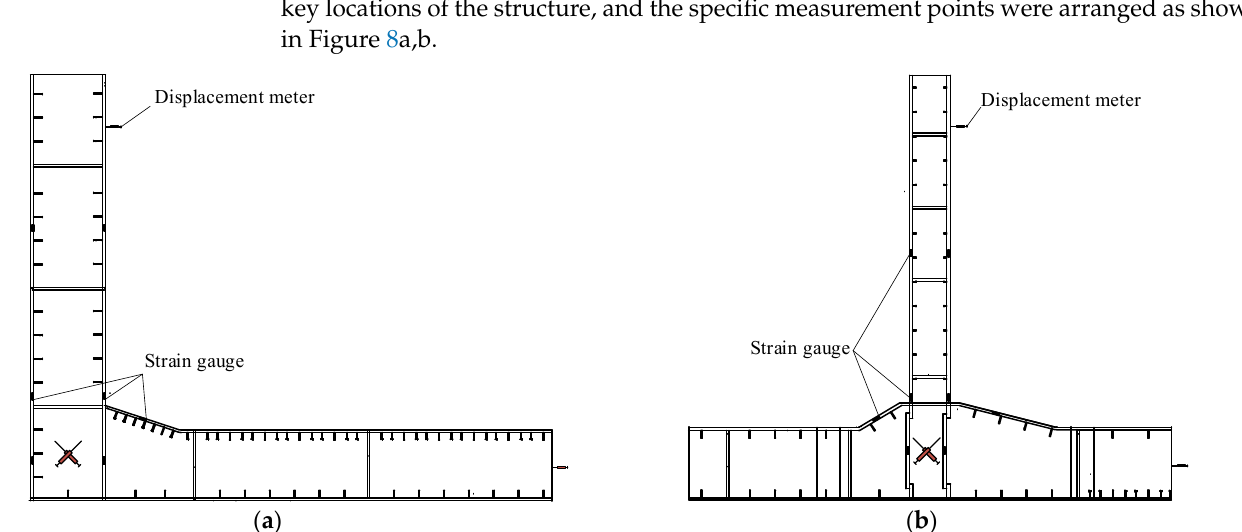
Figure 8. Specimen measurement point layout plan. ( a ) L-shaped specimen; ( b ) T-shaped